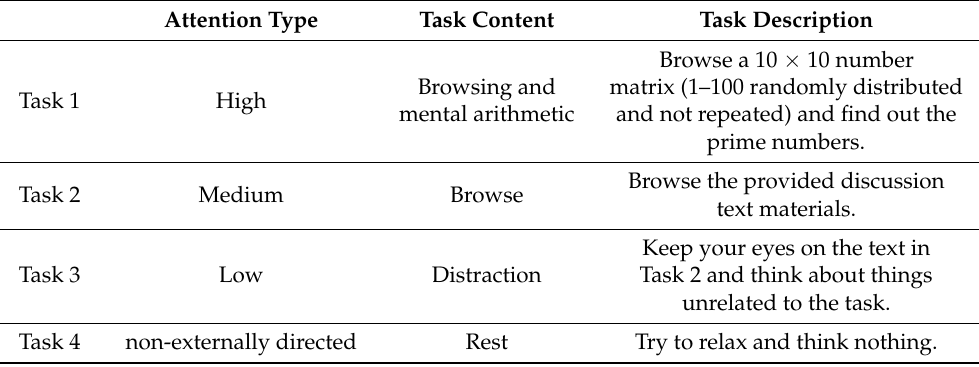
Table 1. Four types of attention